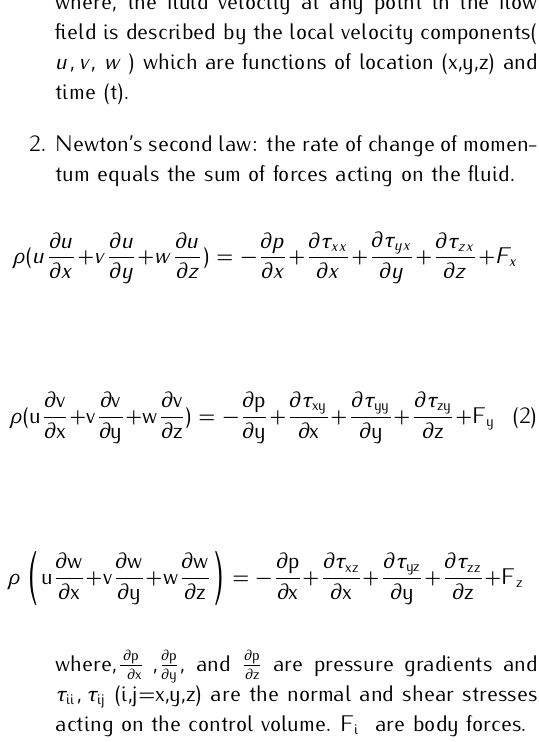
Figure 2. Model of the CMMCT.